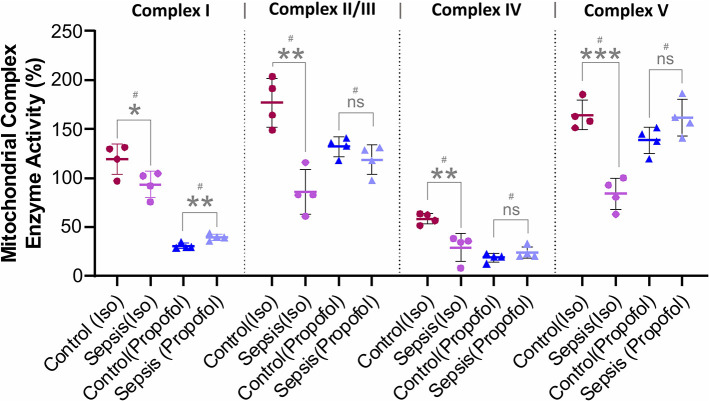
Effect of Sepsis with Isoflurane or Propofol anesthesia on Liver Mitochondrial respiratory chain complex (I, II/III, IV, and V) enzyme activity. Compared to controls isoflurane-sepsis group showed a significant reduction in enzymatic activities of complex-I (*p = 0.047), complex-II/III (**p = 0.001), complex-IV (**p = 0.008), and complex-V (***p = 0.0003). In Propofol sepsis group, except Complex I (**p = 0.005), no significant differences were observed in activities of Complexes II/III, IV, and V. Activity rates are expressed as percentage (%) of the control which had no sepsis. Values are mean ± S.D. (n = 4#/group). #represents pooled samples.